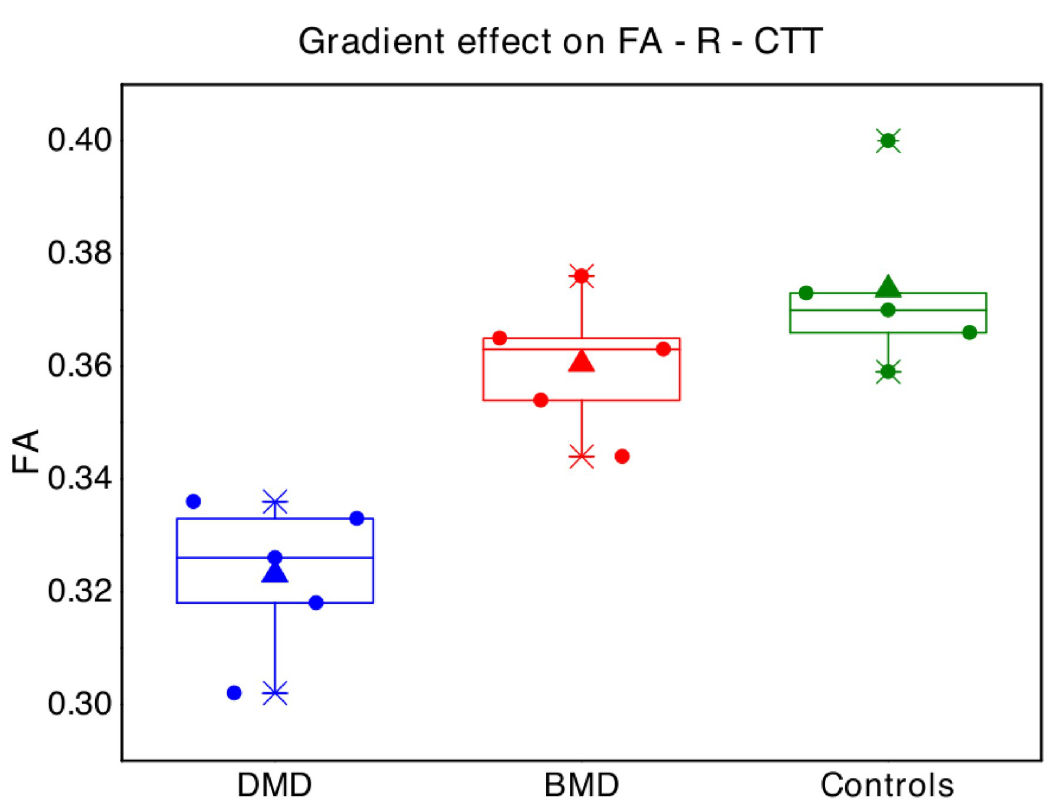
Fig 2. Boxplot represent FA values in the right cerebellar-thalamic tract for each single subject of the three groups (blue points = Duchenne muscular dystrophy children -DMD; red = Becker muscular dystrophy children -BMD; green = typical developing children -TD). The box represents the interval between the 25˚ and 75˚ percentile of data, the lines correspond to the median values, the triangles to the mean values.